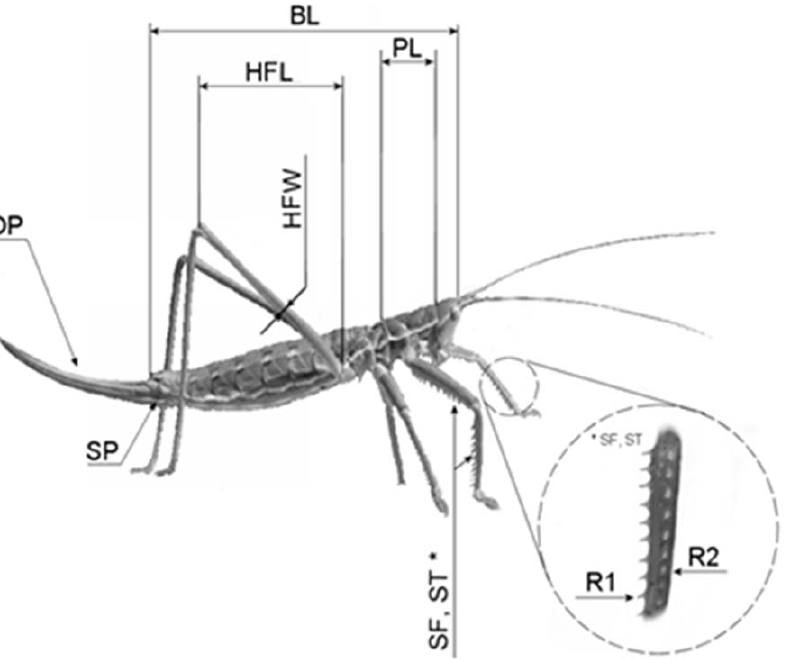
Figure 2. Morphometric parameters measured from the Saga species studied. Abbreviations: BL- length of body; HFL - hind femur length; HFW – maximal width of hind femur; OP – ovipositor; PL – dorsal length of the pronotum; SF - average number of spines of the two row of spines on the femur; SP - subgenital plate; and ST – average number of spines of the two row of spines (R1, R2) on the leg.